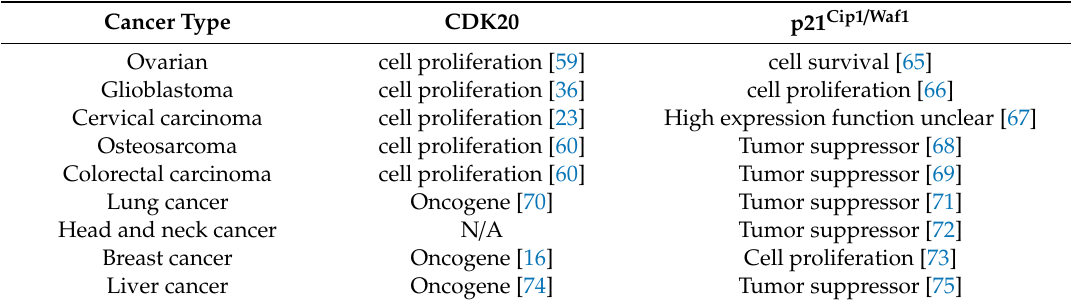
Table 1. Function of CDK20 and p21 Cip1 / Waf1 in cancer cell line /